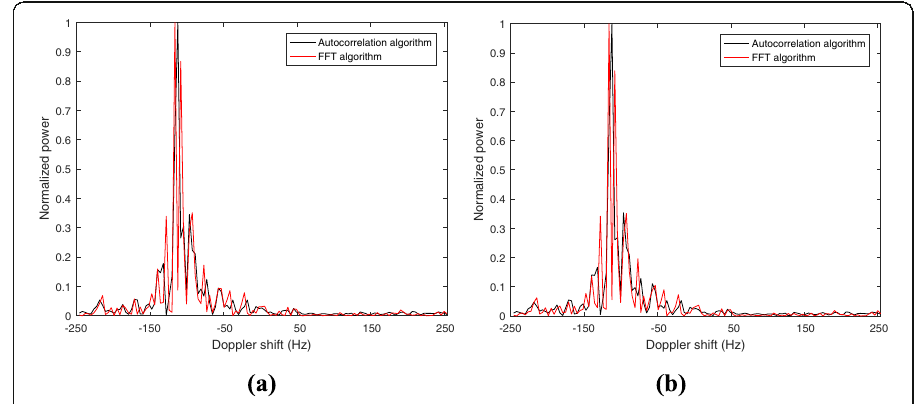
Fig. 6 Power spectrum. a Horizontal polarization power spectrum. b Vertical polarization power